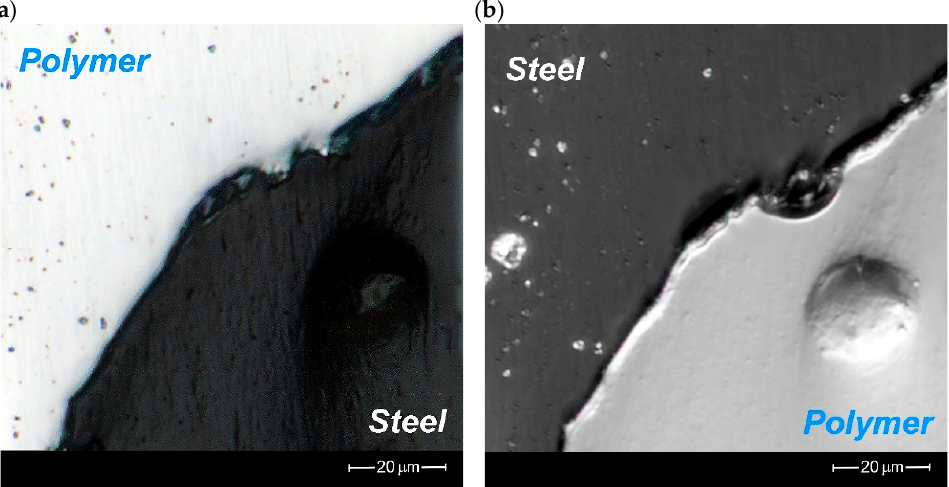
Figure 10. A detailed view of the observed gaps on the prepared surface by polishing after cutting at the ( a ) polymer–metal interface and ( b ) metal–polymer